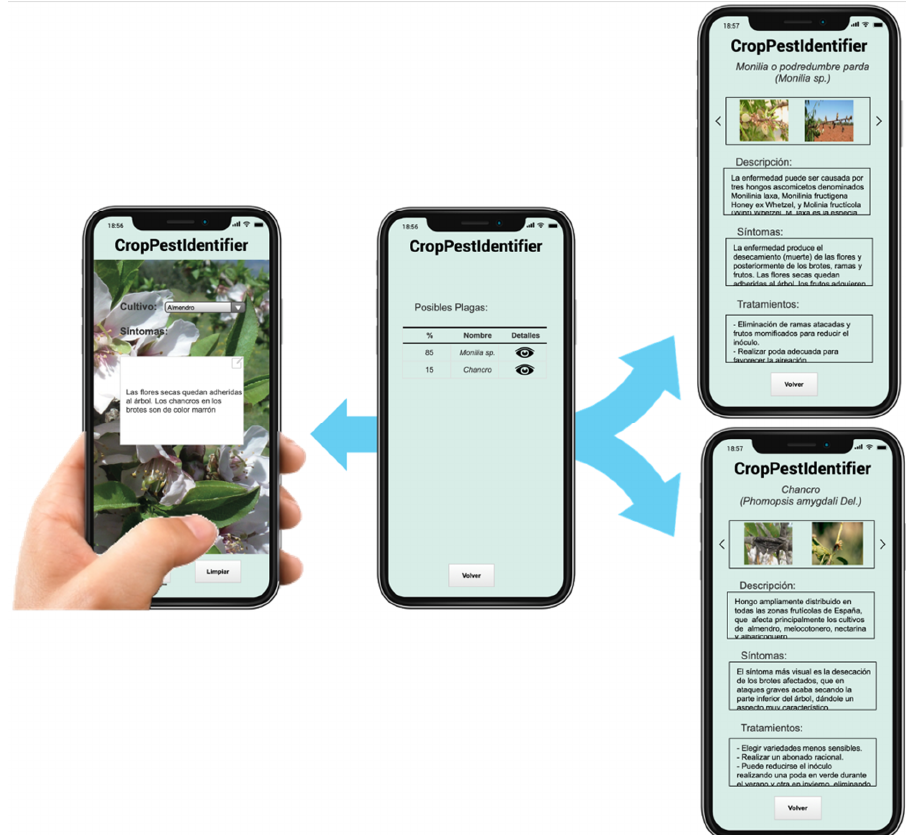
Figure 4. Exemplary use case flowchart (in Spanish). Figure 3. Exemplary use case flowchart (in